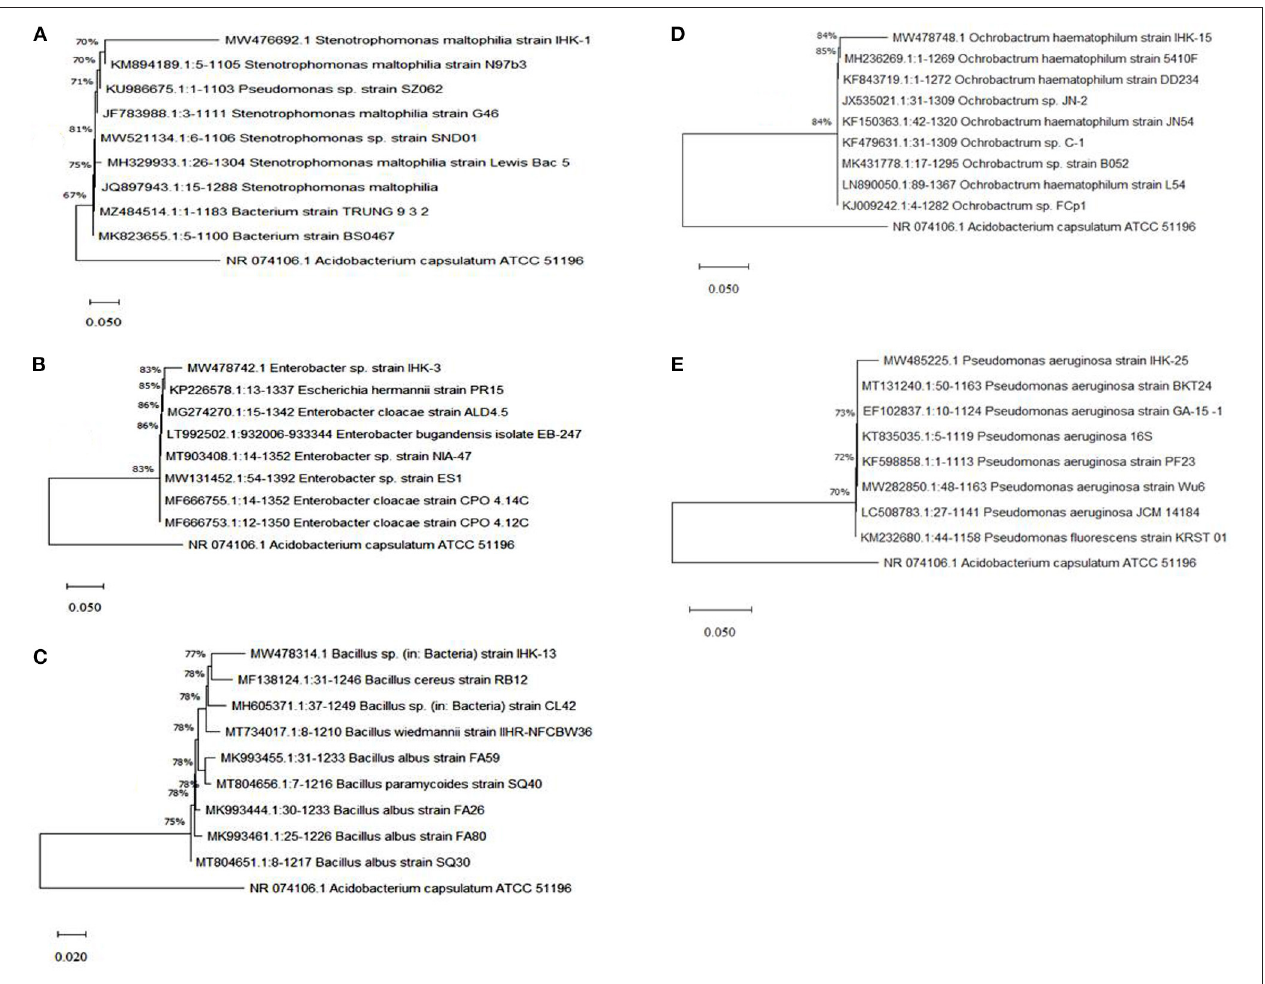
FIGURE 2 | (A–E) Phylogenetic tree of the five isolates (IHK-1, IHK-3, IHK-13, IHK-15, and IHK-25) based on 16S rRNA gene sequences. The neighbor-Joining method was used to construct the phylogenetic tree, and evolutionary analysis was conducted in MEGA X software and 16S sequence of Acidobacterium capsulatum (phylum Acidobacteria) was used as an outgroup. The bar represents 0.05 substitutions per site.